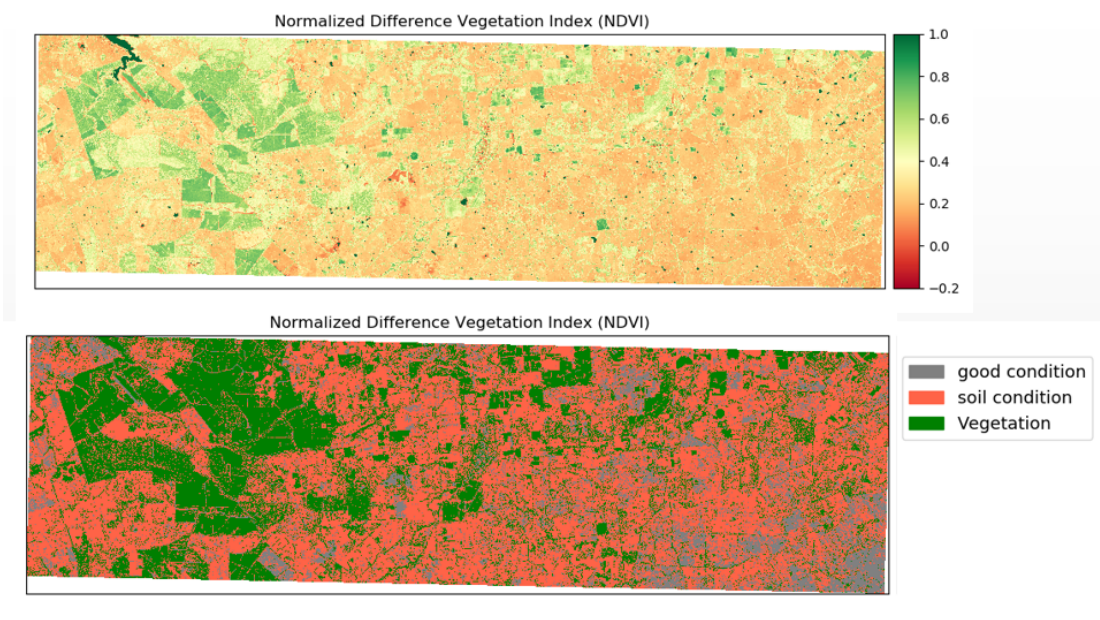
Figure 10. NDVI index and NDVI classes results for GeoEye’s OrbView–3 satellite dataset.